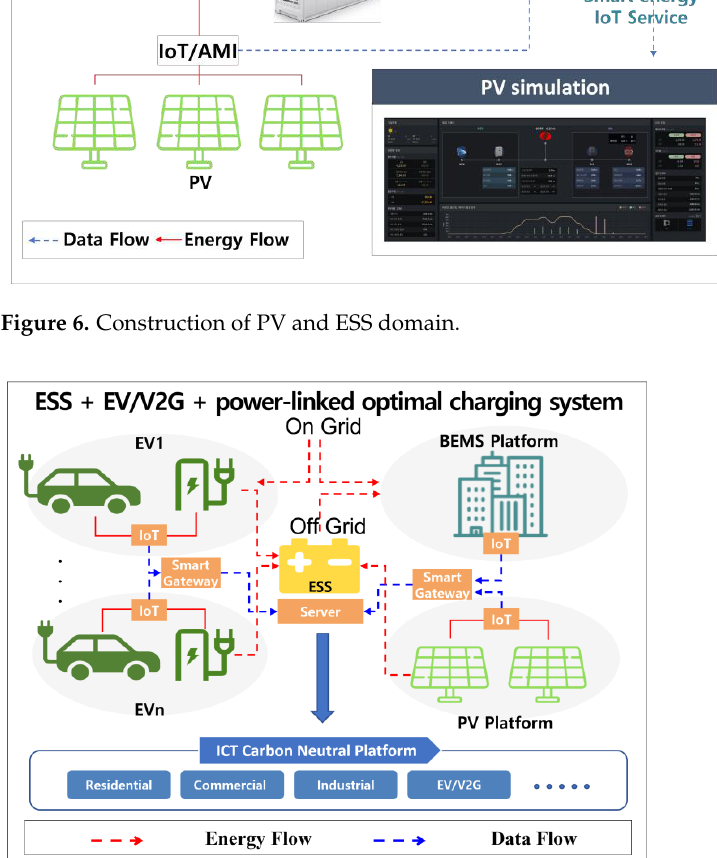
Figure 6. Construction of PV and ESS domain.